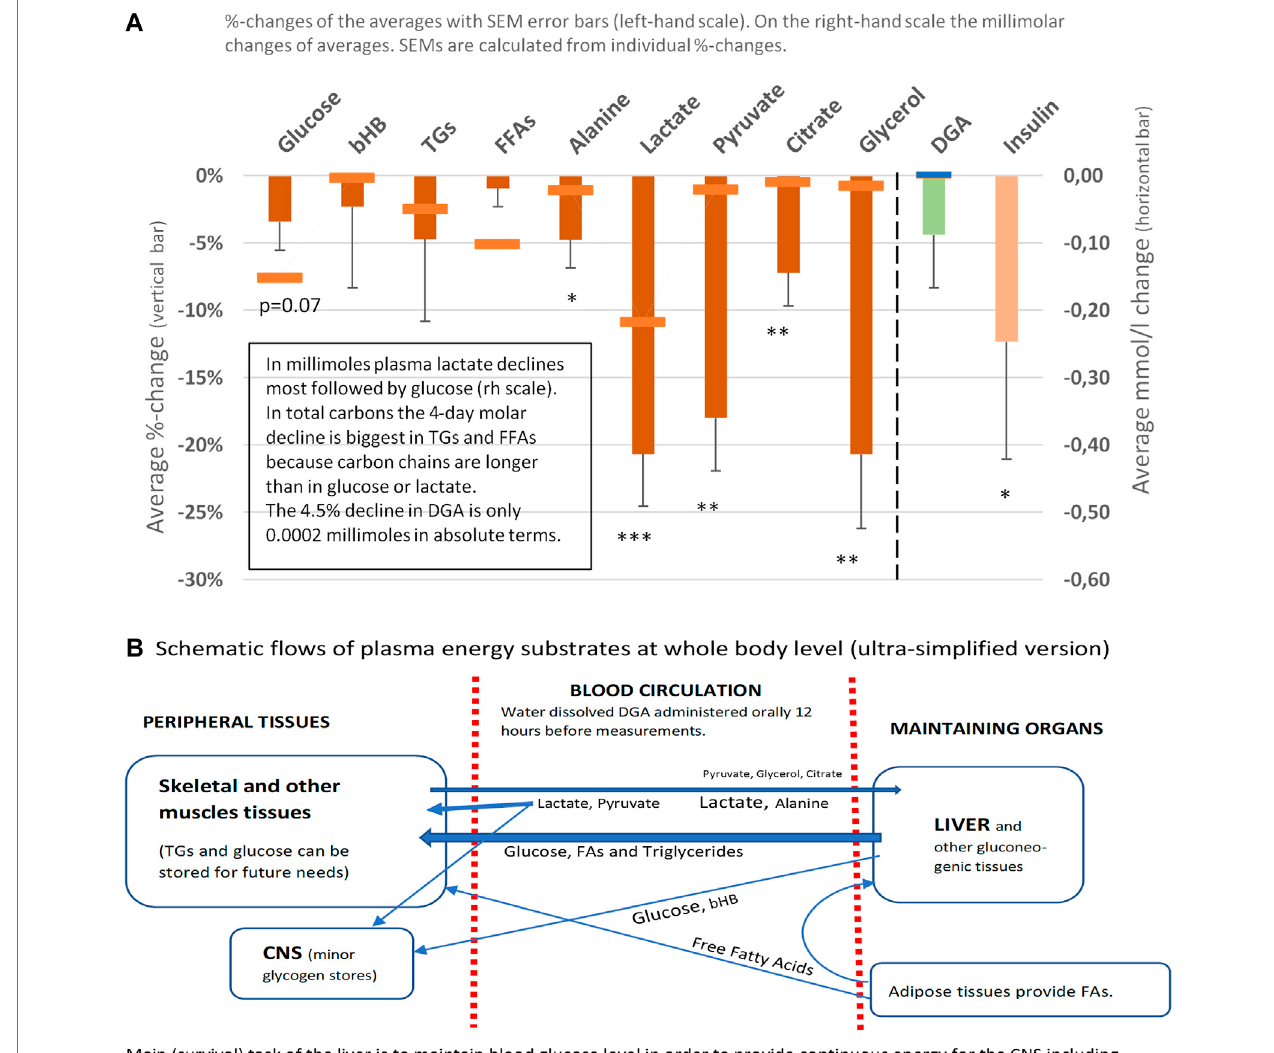
FIGURE 2 | Representative energy substrates under the 4-days DGA regimen, 12 h from last DGA dose, and DGA and insulin (A) . Schematic fl ows of all reported plasmaenergysubstratesatwhole-bodylevel (B) .Statisticaltestsarebasedonintra-individualchanges(paired t -tests).Errorbarsarestandarderrorsofthemean(SEM) of the individual